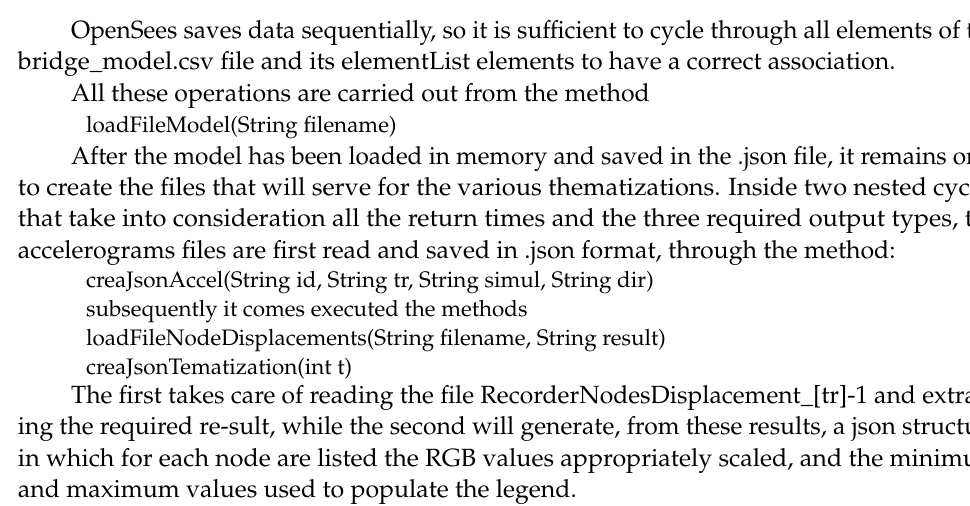
Figure 17. OpenSees with the sections of each